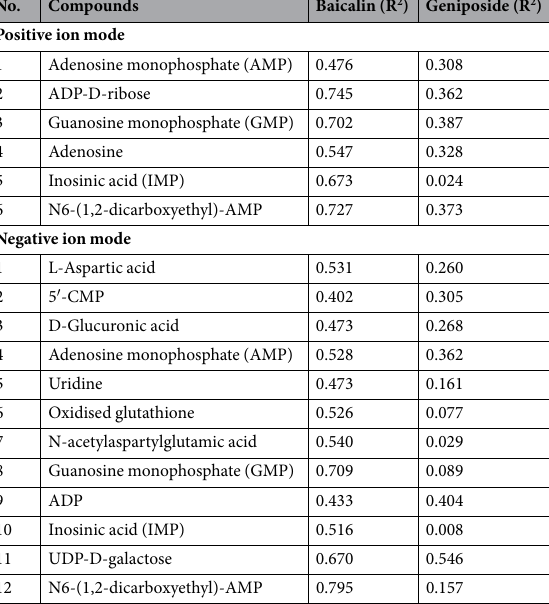
Table 3. The correlation coefficients between baicalin, geniposide and potential